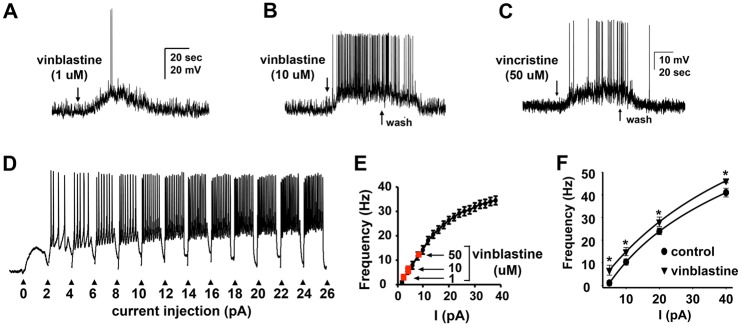
Vinca alkaloids increase the excitability of C4da sensory neurons.A-C, Representative traces from current-clamped C4da neurons show that exposure to vinblastine (A, B) or vincristine (C) immediately depolarizes the neuron and generates action potentials that is sensitive to the dose and presence of the drug. D and E, Current injections determine the relationship between current and firing frequency in C4da neurons (D). These analyses reveal that the firing frequencies resulting from vinca alkaloids (E) are consistent with amplitudes of the resulting current measured in voltage-clamp. Data for vinblastine (1, 10, and 50 μM) are indicated in red. Points represent average values. Error bars = SEM, n = 8–15 neurons per condition. (F) Graph represents the relationship between current injection and action potential frequency in the presence (arrowhead) and absence (circle) of sub-threshold concentrations of vinblastine. Each point represents the average frequency. Error bars = SEM, n = 3–5 neurons per condition. *p<0.05 determined via Student’s T-test for vinblastine vs. control for each current injection.